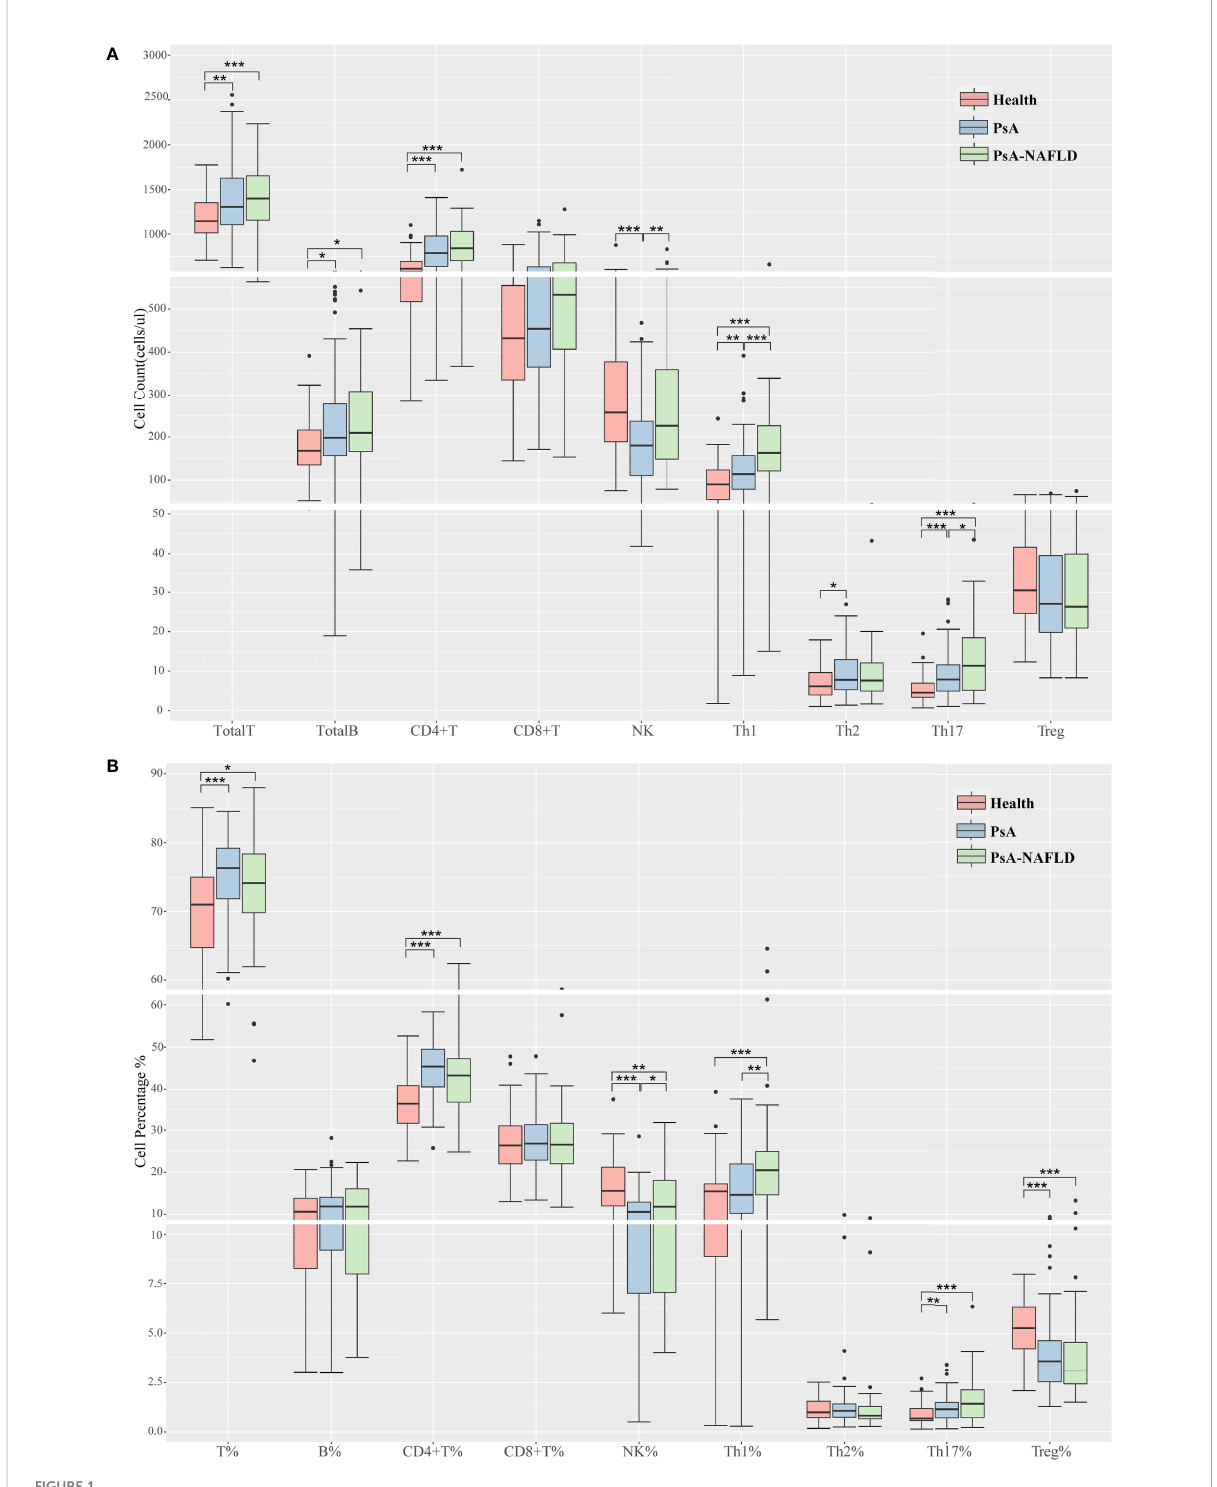
FIGURE 1 (A) . Comparison of peripheral blood lymphocyte subsets and CD4+T cell counts among each study group. (B) . Comparison of the proportion of peripheral blood lymphocyte subsets and CD4+ T cells among each study group. (* p < 0.05, ** p < 0.01, *** p <